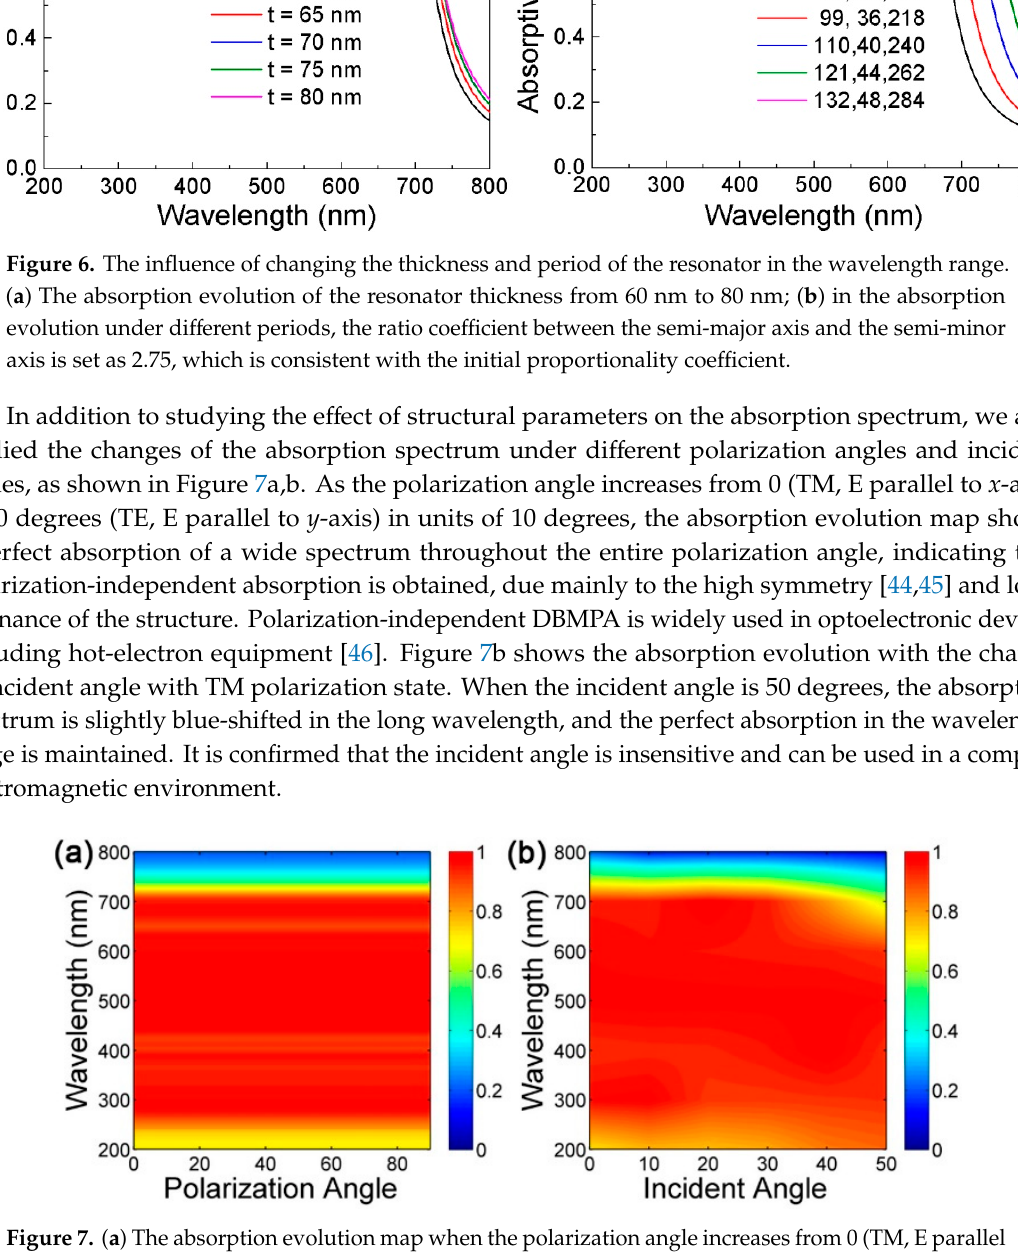
Figure 7. ( a ) The absorption evolution map when the polarization angle increases from 0 (TM, E parallel to x -axis) to 90 degrees (TE, E parallel to y -axis); ( b ) the absorption evolution map with the change of incident angle from 0 to 50 degrees with TM polarization